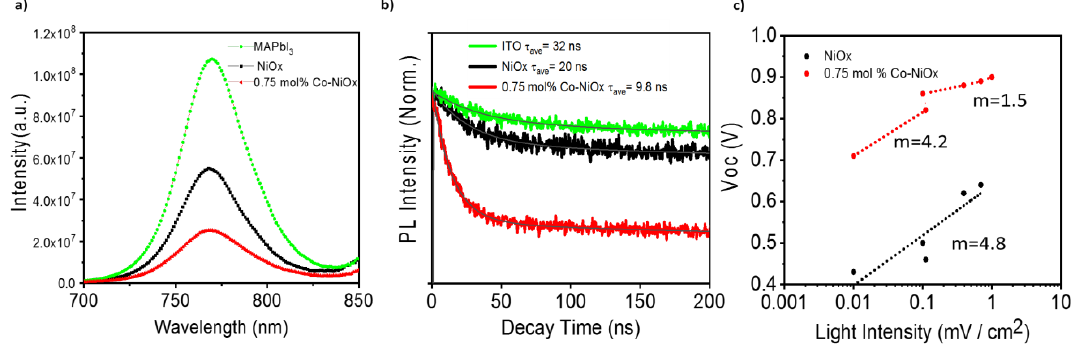
Figure 7. ( a ) Photoluminescence (PL) of MAPbI 3 films on top of NiO x and 0.75 mol% Co-NiO x . The MAPbI 3 on top of glass was used as a reference measurement; ( b ) time-resolves PL of the corresponding samples; ( c ) V oc vs. different light intensity for 0.75 mol% Co-NiO x and NiO x .